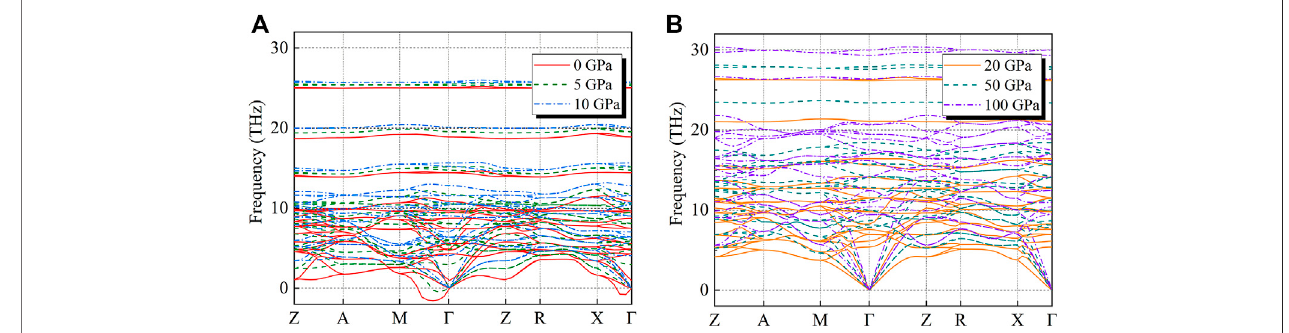
FIGURE 3 | (A,B) show the phonon dispersion relations along with select high-symmetry points in the Brillouin zone for CaO 3 at (A) 0 (solid red lines), 5 (dashed olive green lines), 10 (dot-dash blue lines), (B) 20 (solid orange lines), 50 (dashed dark green lines), and 100 GPa (dot-dash purple lines).